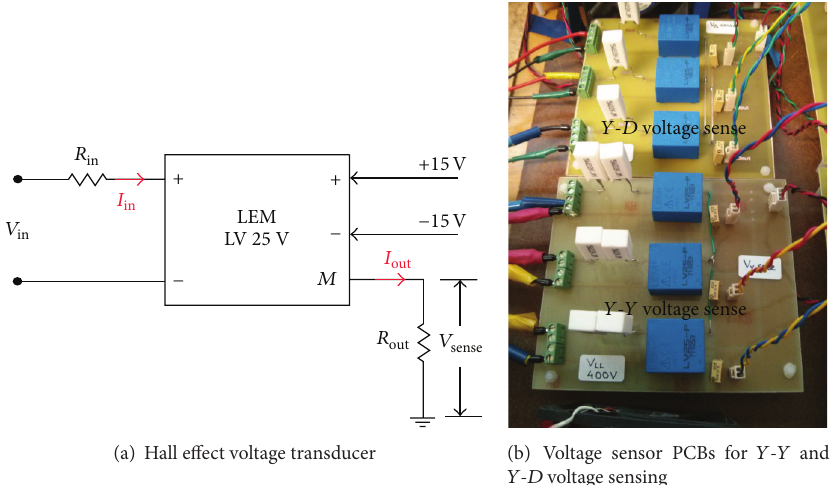
Figure 16: Voltage transducer circuit and fabricated PCB.